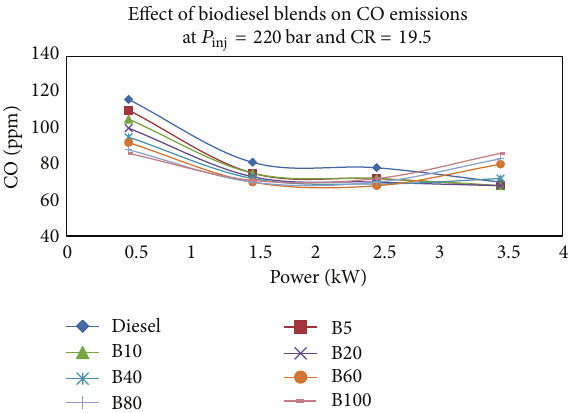
Figure 22: Variation in CO for various biodiesel blends at 𝑃 inj 220 bar and CR 19.5.